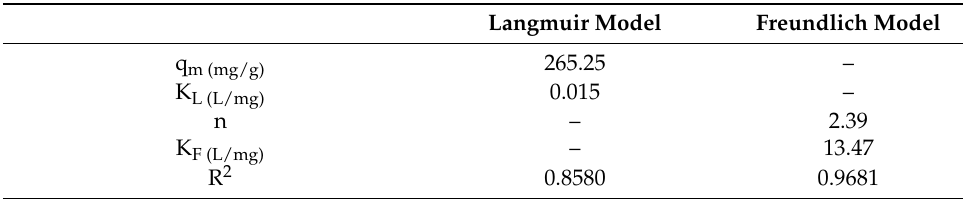
Table 1. Some key parameters for the two adsorption models.